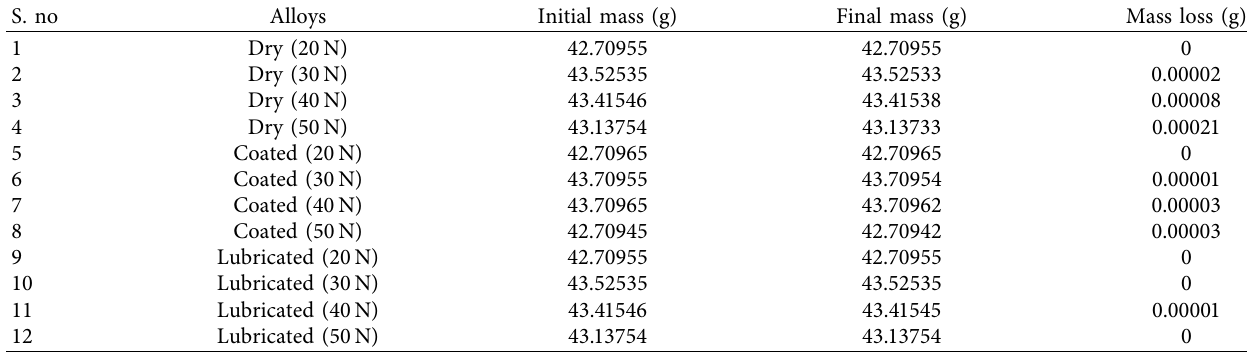
Table 1: Weight of samples before and after wear test of AlSi24 composite.